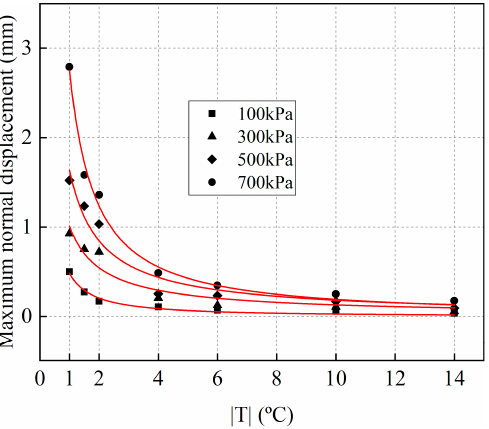
Figure 15. Fitting curve of the maximum normal displacements with temperatures for different normal stresses.